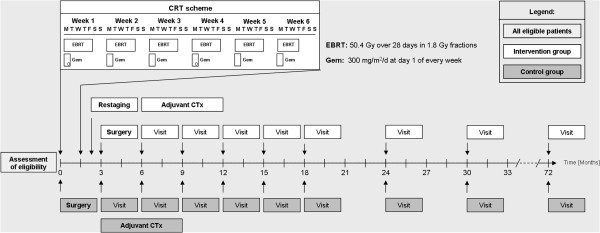
Follow-up and study visits. Study visits will be performed in 3-months intervals within the first 18 months and in 6-months intervals thereafter. Total follow-up will be 24 months after end-of-recruitment or 36–72 months after randomization.